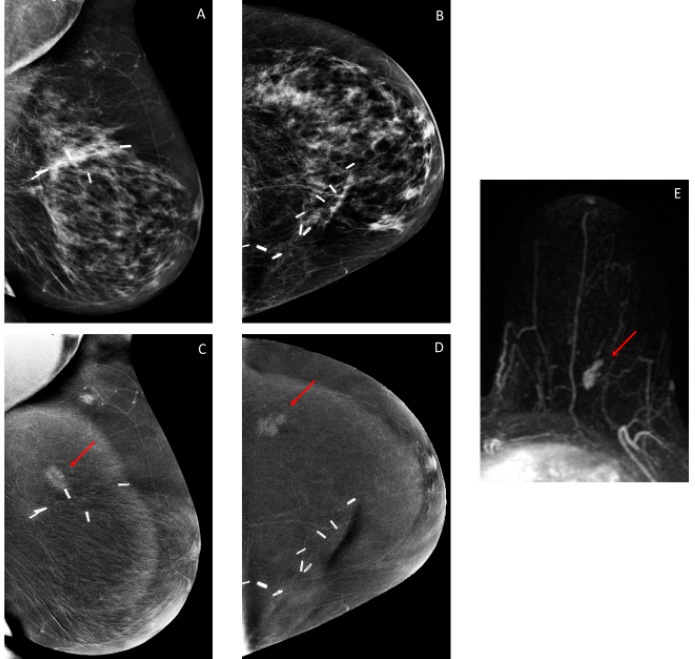
Figure 4. Sixty-five-year-old woman treated with left breast conservation surgery 17 years prior for invasive ductal carcinoma (IDC) and ductal carcinoma in situ (DCIS). Screening CEM shows no